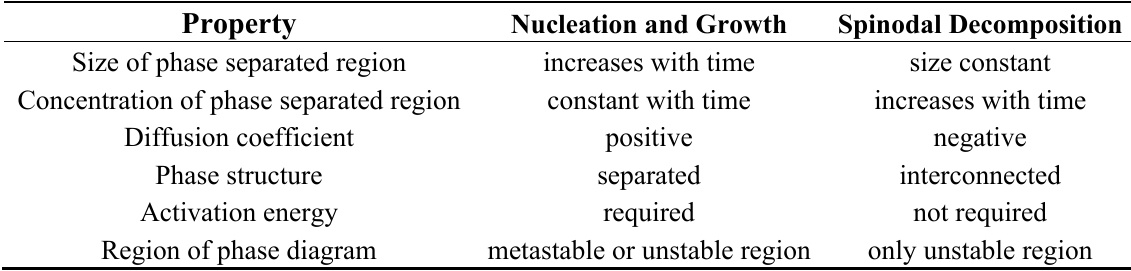
Table 1. Comparison of Phase Separation Processes.